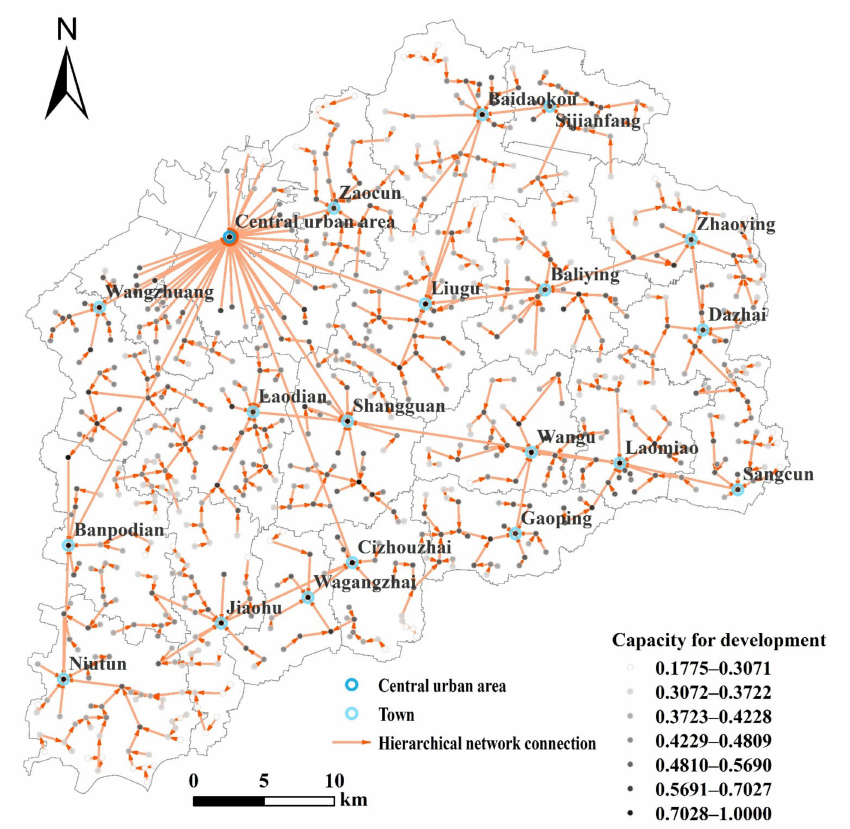
Figure 5. Identification of the spatial hierarchical network structure of urban and rural settlements in Hua